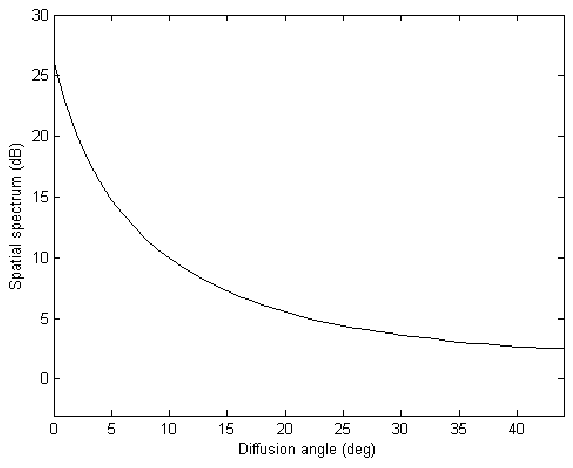
Figure 2. Spatial spectrum versus the diffusion angle.